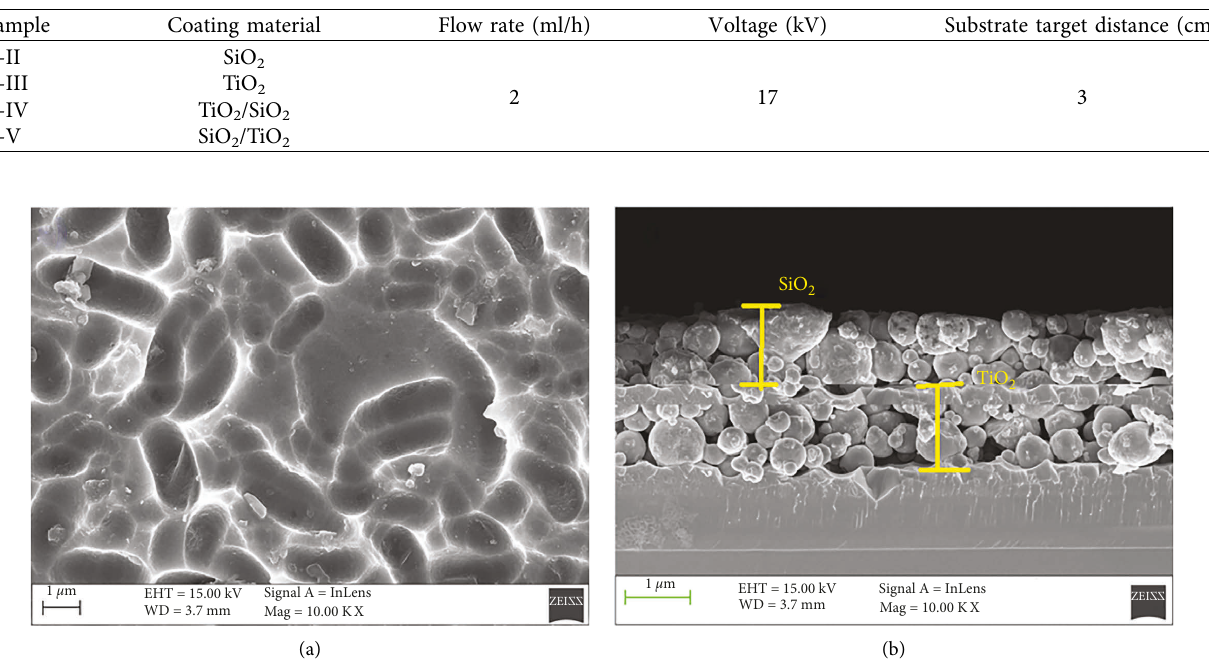
Figure 2: (a) Surface morphology of B-IV (TiO 2 /SiO 2 ). (b) Cross-section of B-IV (TiO 2 /SiO 2 ) solar cells.